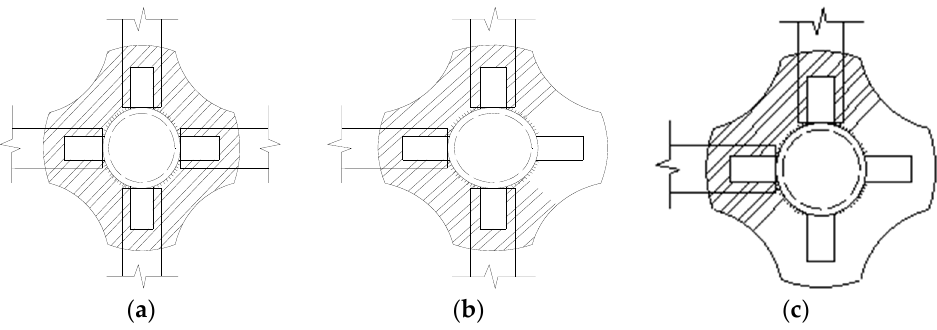
Figure 11. Schematic diagrams of the wheel shear zone: ( a ) Central pole; ( b ) side pole; ( c ) corner